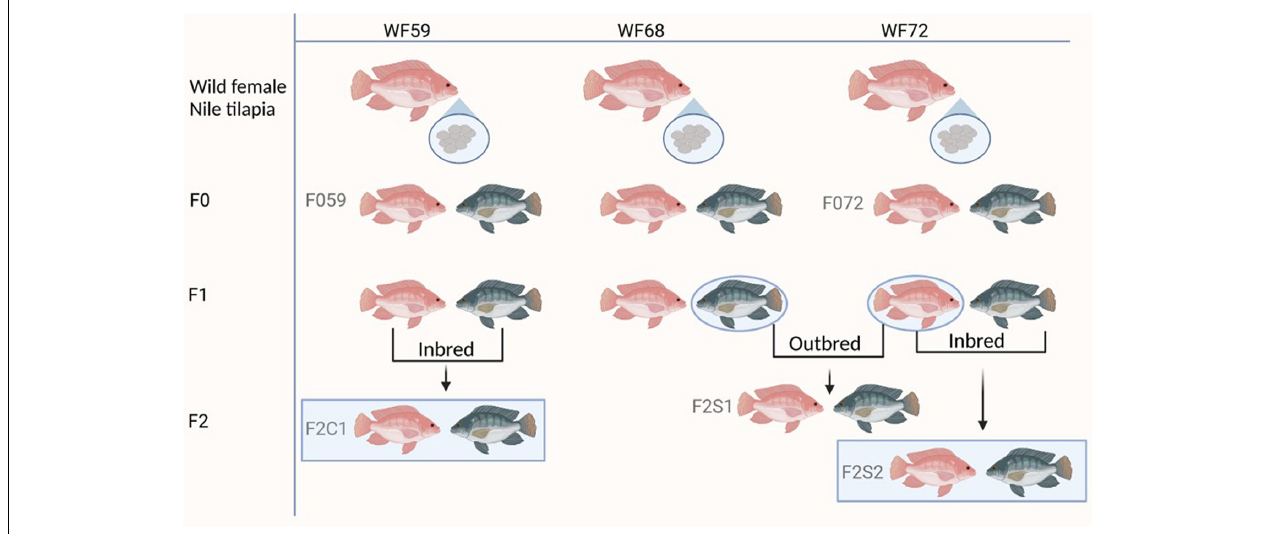
FIGURE 1 | Breeding plan of the different generations of Nile tilapia. F0 generation: F059 and F072; F2 generation: F2C1, F2S1, and F2S2. Inbred groups (F2C1 and F2S2) and outbred (F2S1). WF59, W68, and WF72 are the wild mothers. The pink color represents female and gray male